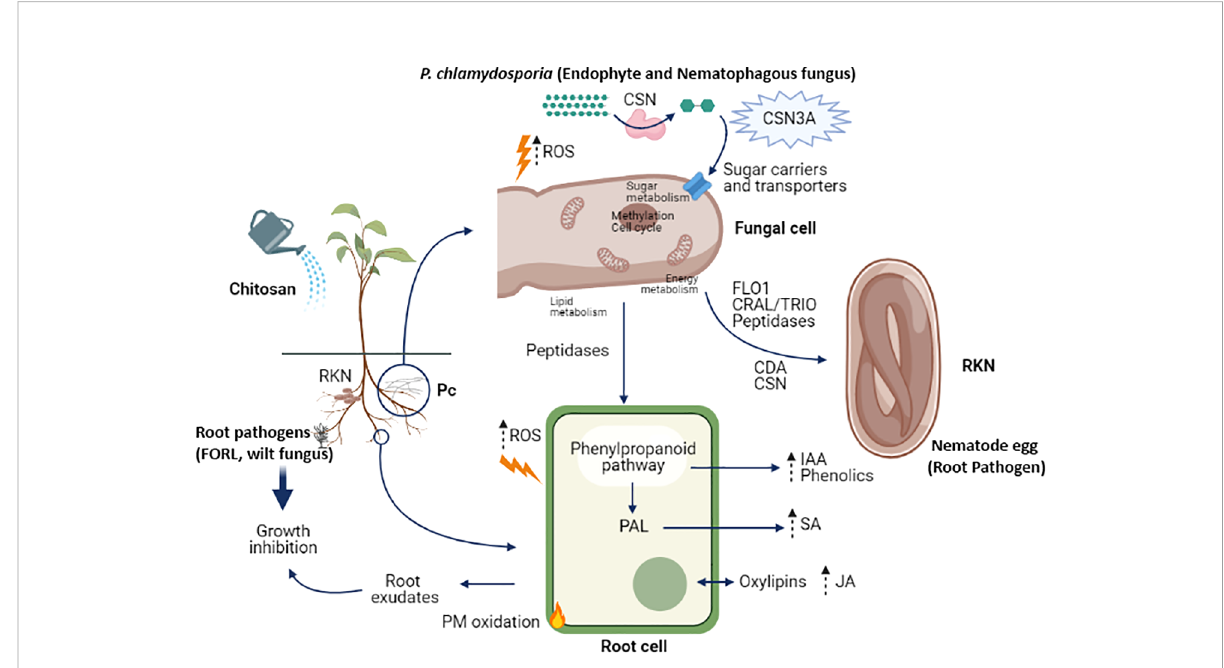
FIGURE 3 Cell and molecular effects of chitosan in the rhizosphere. Abbreviations: RKN (root-knot nematodes), FORL ( Fusarium oxysporum f. sp. radicis lycopersici), ROS (reactive oxygen species), CSN (chitosanase), CSN3A (chitosanase 3 isoform A), CDA (chitin deacetylase), IAA (Indole-3-acetic acid), SA (salicylic acid), JA (jasmonic acid), PAL (phenyl ammonia lyase), PM (plasma